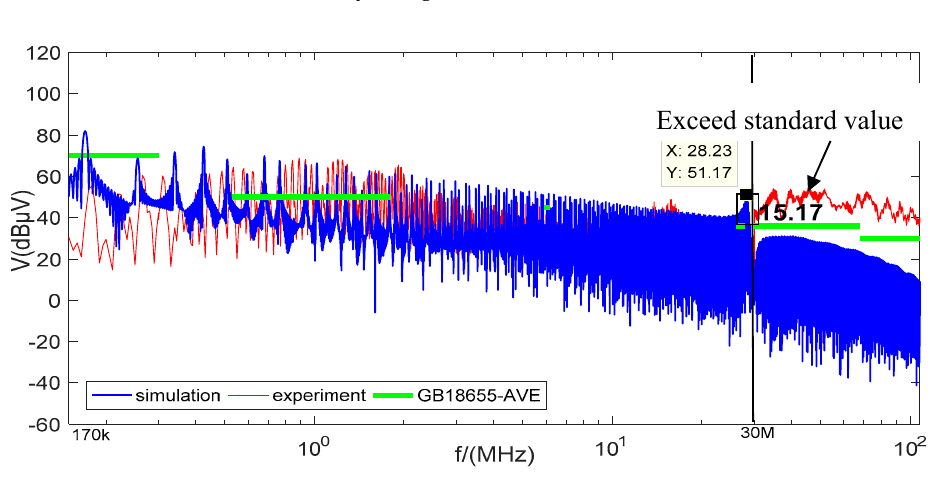
Figure 18. Simulation results for CM conducted voltage.